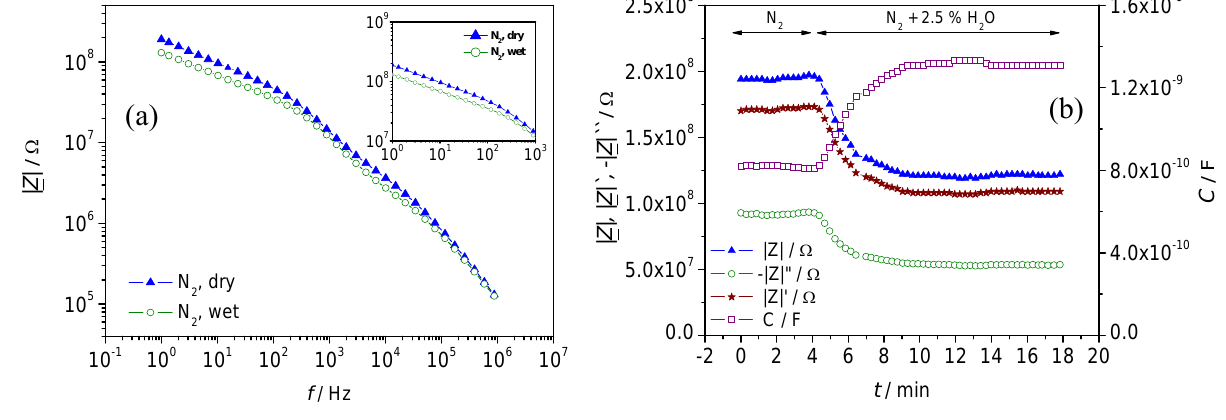
Figure 2. Impedimetric sensor response to variations in the humidity of the test gas. Pellet- type sensor of Al-BDC. (a) Measurements in a frequency range between 1 Hz - 1 MHz in carrier gas. (b) Time dependent measurements at 1 Hz when the dry and wet N 2 surrounding gas is varied stepwise from dry N to N with 2.5 vol% H O. T = 120 °C. 2 2 2